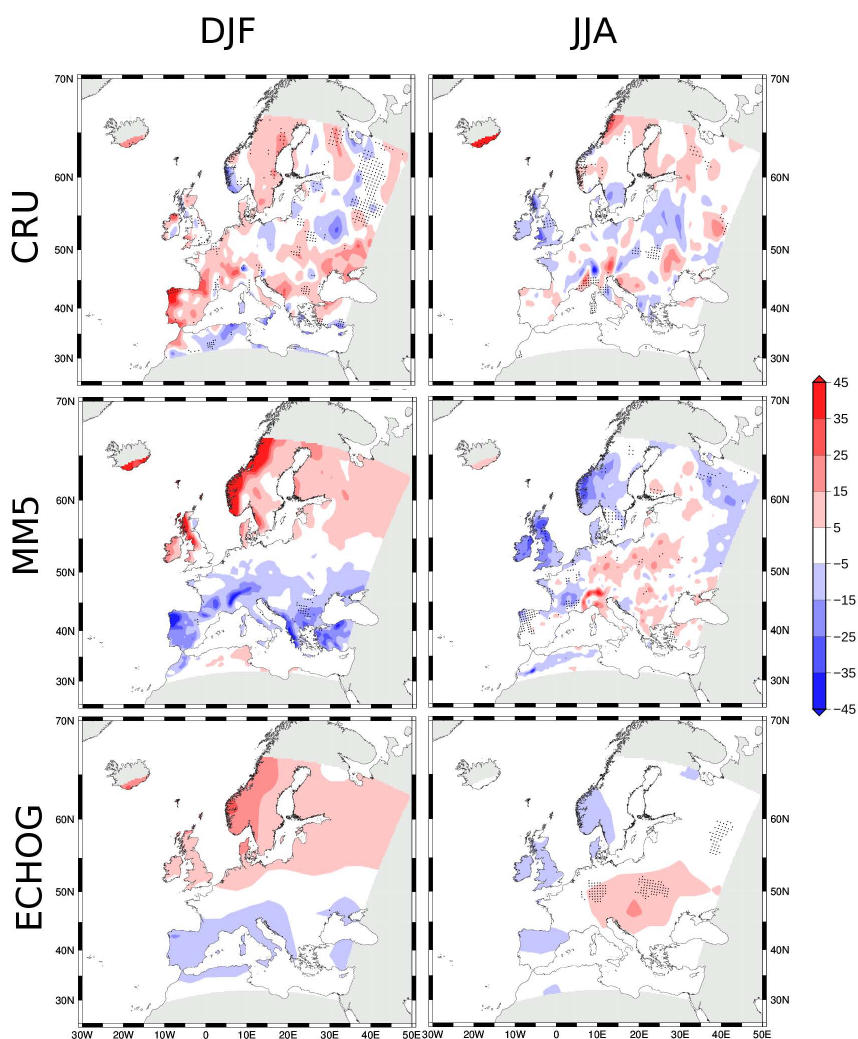
Fig. 9. Trends (in mmmonth − 1 century − 1 ) in the seasonal precipitation series in the 1900–1990 period for winter (left panels) and summer (right panels) in CRU (top panels) MM5 driven by ECHO-G (middle panels), and ECHO-G alone (bottom panels). To perform the calcula- tions, all datasets are spatially interpolated onto the MM5 grid, and only non-ocean grid cells are considered. The significance of the trends is tested through the Mann–Kendall test, and it is indicated with small black circles in the